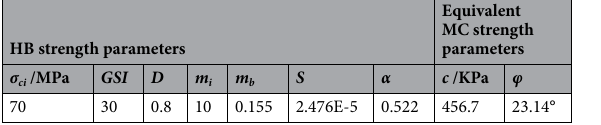
Table 2. Strength parameter.